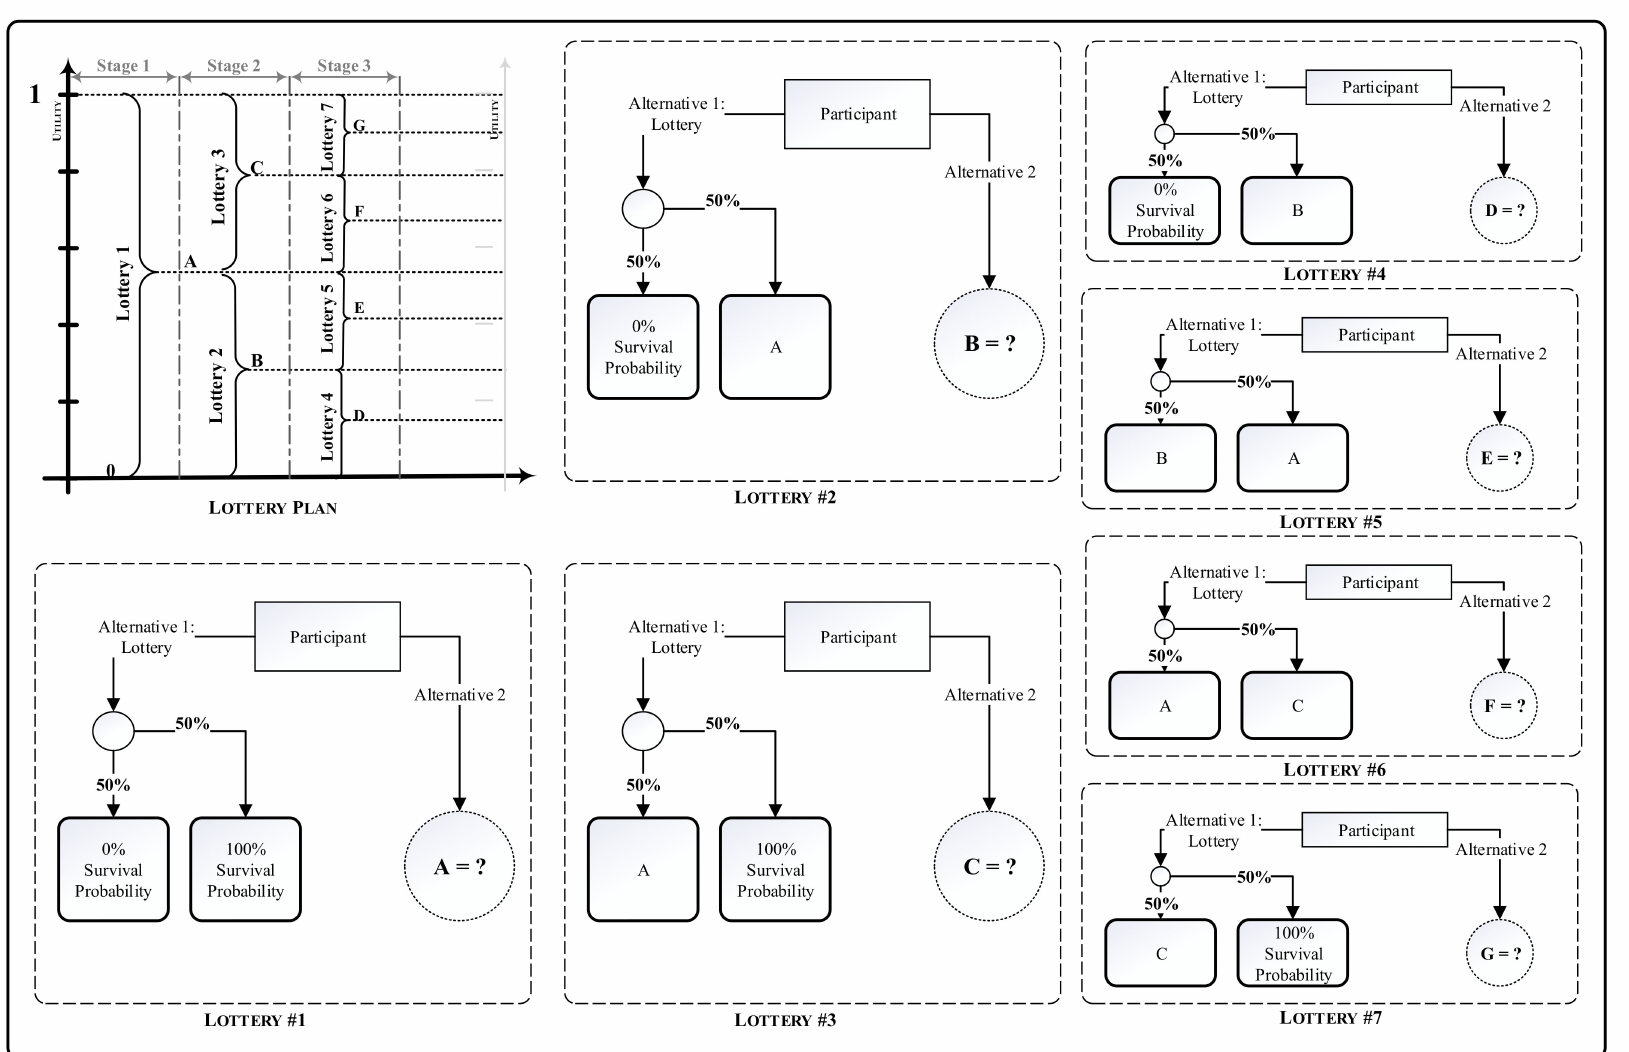
Figure 2. Interview structure based on SG technique. SG, standard